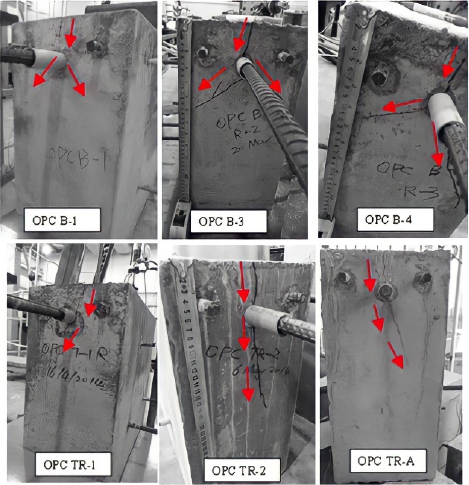
Figure 5. Examples of pull out face cracks in GPC beams (faint cracks are highlighted with red arrows).